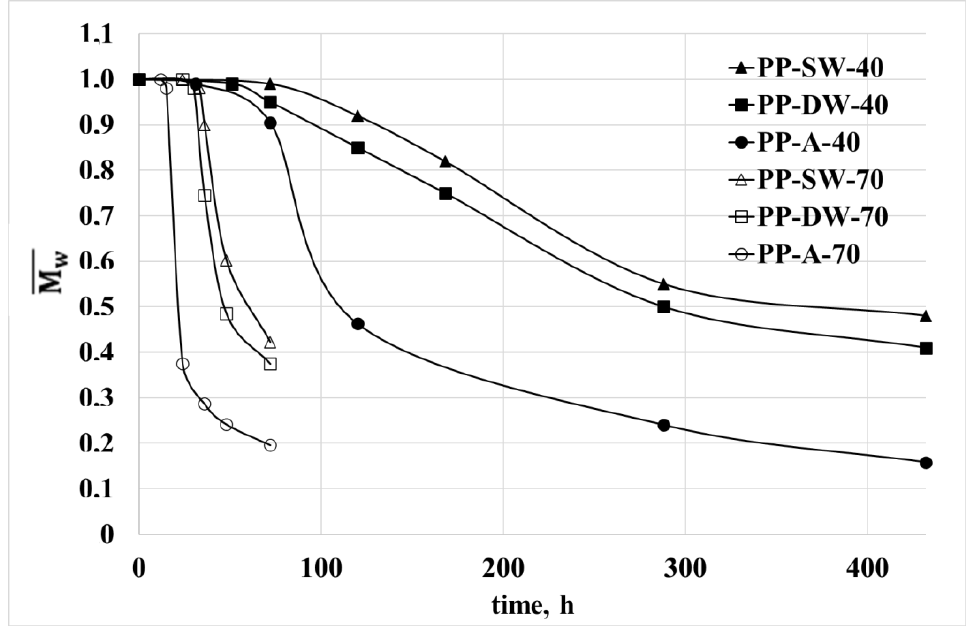
Figure 3. Dimensionless molecular weight as a function of the irradiation time in all the environ- mental conditions.